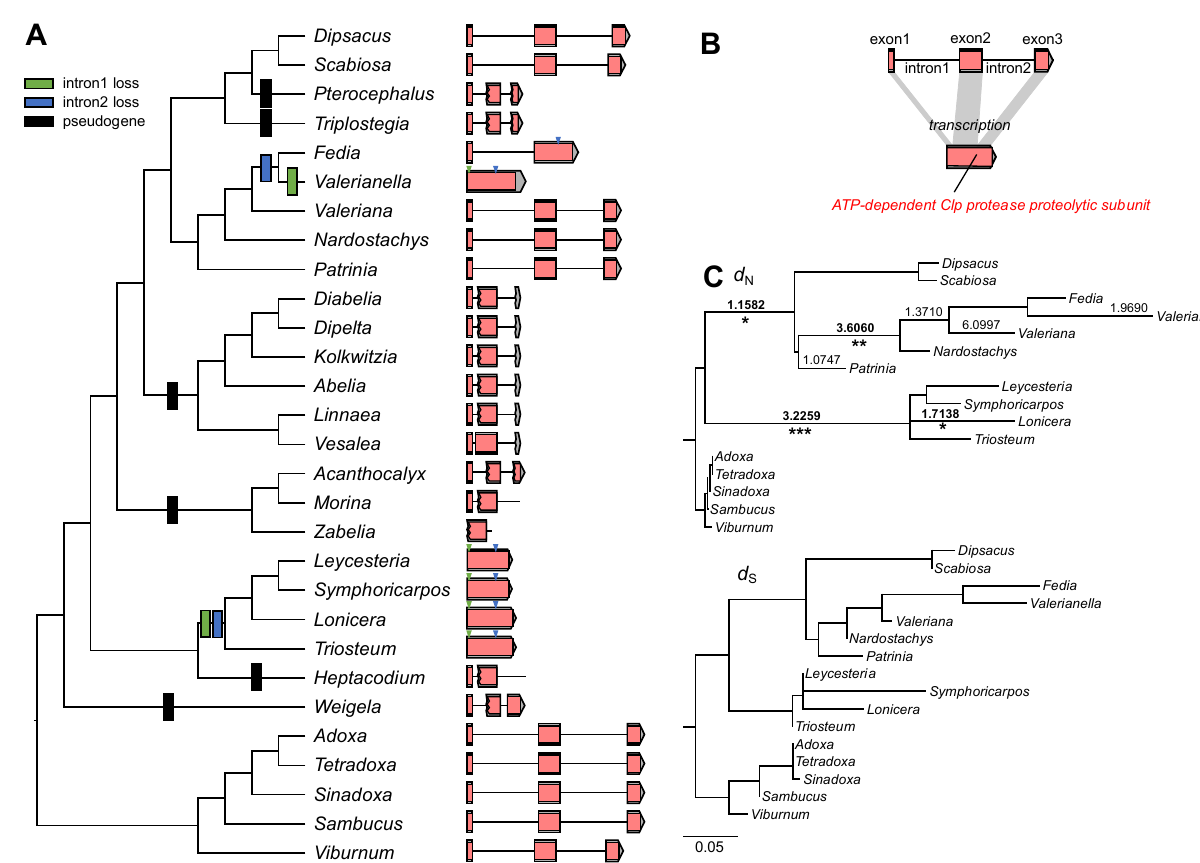
Figure 5. Structural evolution of the clpP gene: A) phylogenetic distribution of pseudogene or intron loss among the selected Caprifoliaceae s.l. and five outgroups. Arrowheads indicate the positions of the first (green) and second (blue) intron; B) schematic diagram of the structure of clpP . Pink boxes indicate the conserved domain of caseinolytic protease; C) phylograms showing nonsynonymous ( d N ) and synonymous ( d S ) substitution rates for the clpP genes among 16 species that have intact gene sequences. Branch lengths are drawn to the same scale based on d N and d S substitutions per site. Branches with significantly higher d N / d S ratios determined by likelihood ratio test are marked with asterisks (*, p < 0.05; **, p < 0.01; ***, p < 0.001 after Bonferroni correction).